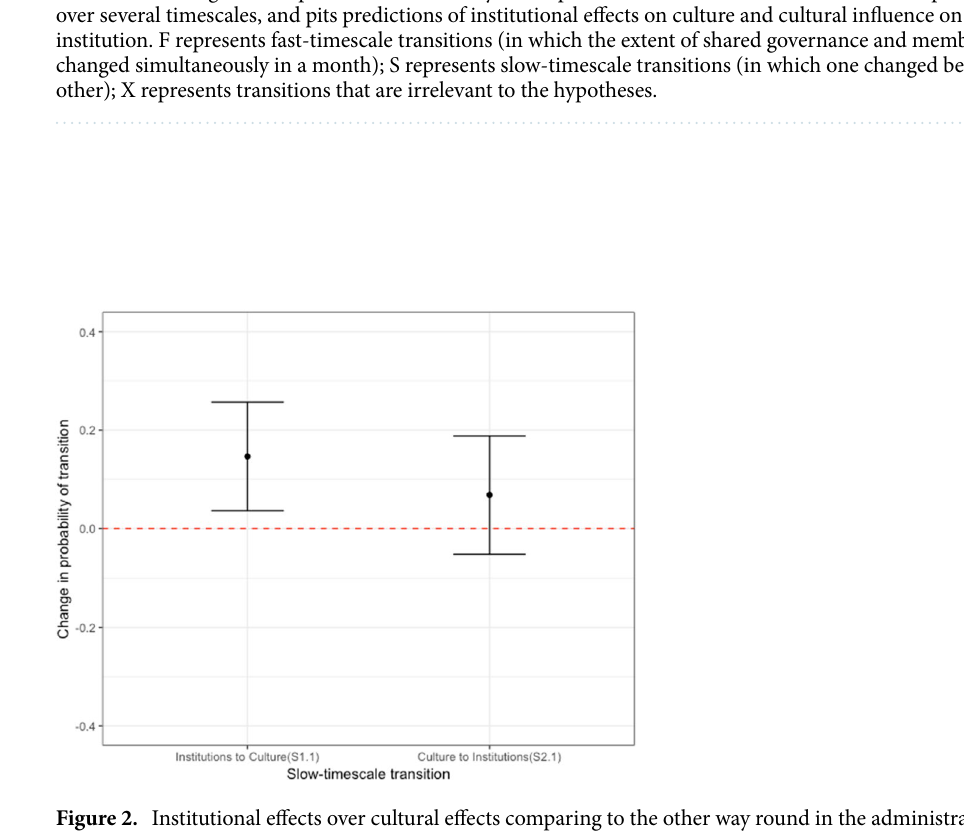
Figure 2. Institutional effects over cultural effects comparing to the other way round in the administrative rule type Among plugins that focus on administrative rule type, two communities with the same focus on administrative capacity are more likely to have shared traffic, while two communities with different degrees of reliance on this rule type are less likely to have a shared